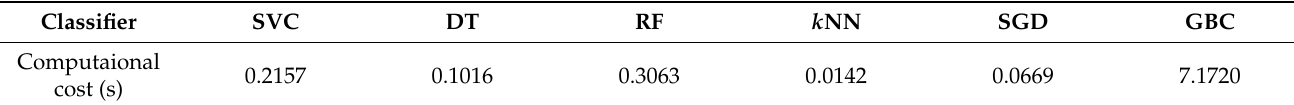
Table 7. An average computational time display of training and testing